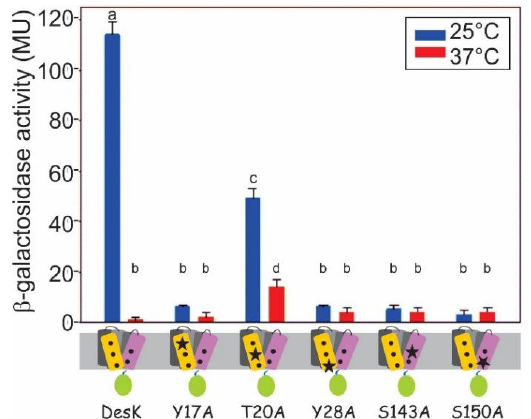
Figure 3. Role of interhelical H-bonds in full length DesK. B. subtiliss. ∆desk cells expressing full length DesK and variants with the indicated mutations were grown at 25 °C and 37 °C, as described in Figure 1C. β -galactosidase activity was measured and expressed in Miller Units (MU). Error bars include the standard deviation from at least three independent experiments. There is not significant difference among activities labeled with the same letter. There is significant difference among activities labeled with different letters. In the bottom panel, TMSs are represented as cylinders of different colors and the mutations are highlighted with a black